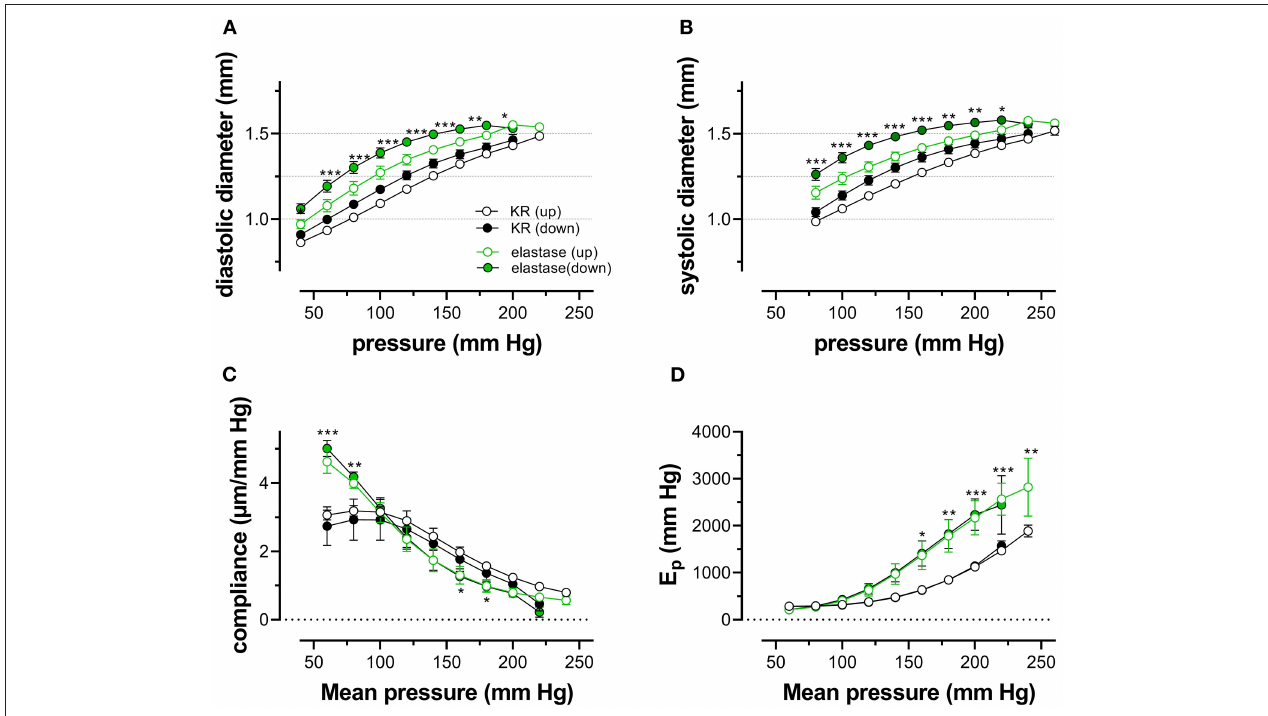
FIGURE 8 | Diastolic and systolic diameters, compliance, and stiffness are elastin dependent. Diastolic diameter (A) , systolic diameter (B) , compliance (C) , and Peterson modulus, E p (D) , were measured in aortic segments in control conditions (black symbols) or after treatment with 0.1 unit/ml elastase (green symbols). Data points for the upward pressure steps (open symbols, up) were compared at any given pressure with data points for the downward pressure steps (closed symbols, down). Two-way RM ANOVA with Sidak’s multiple comparison test (elastase vs. control), * p < 0.05, ** p < 0.01, *** p < 0.001, n =